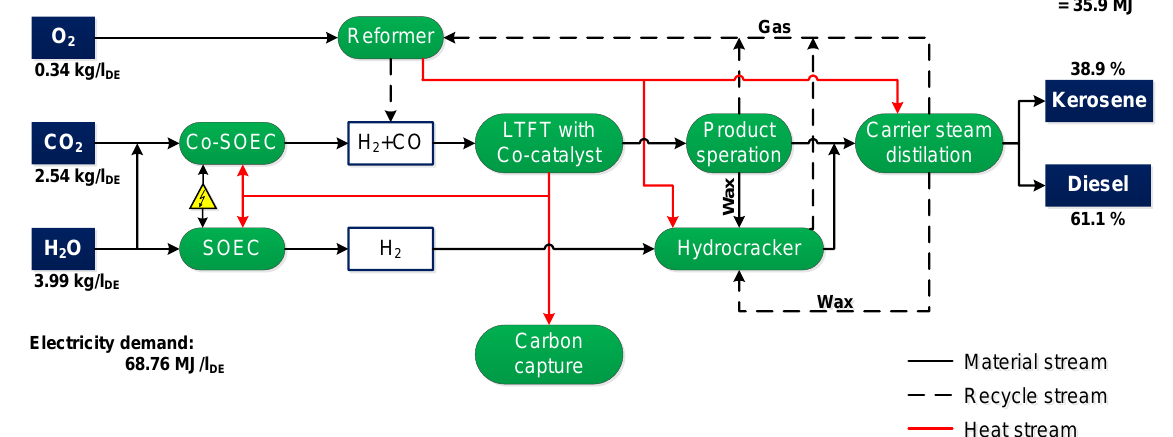
Figure 11. Energy-specific material balance of the developed fuel synthesis.